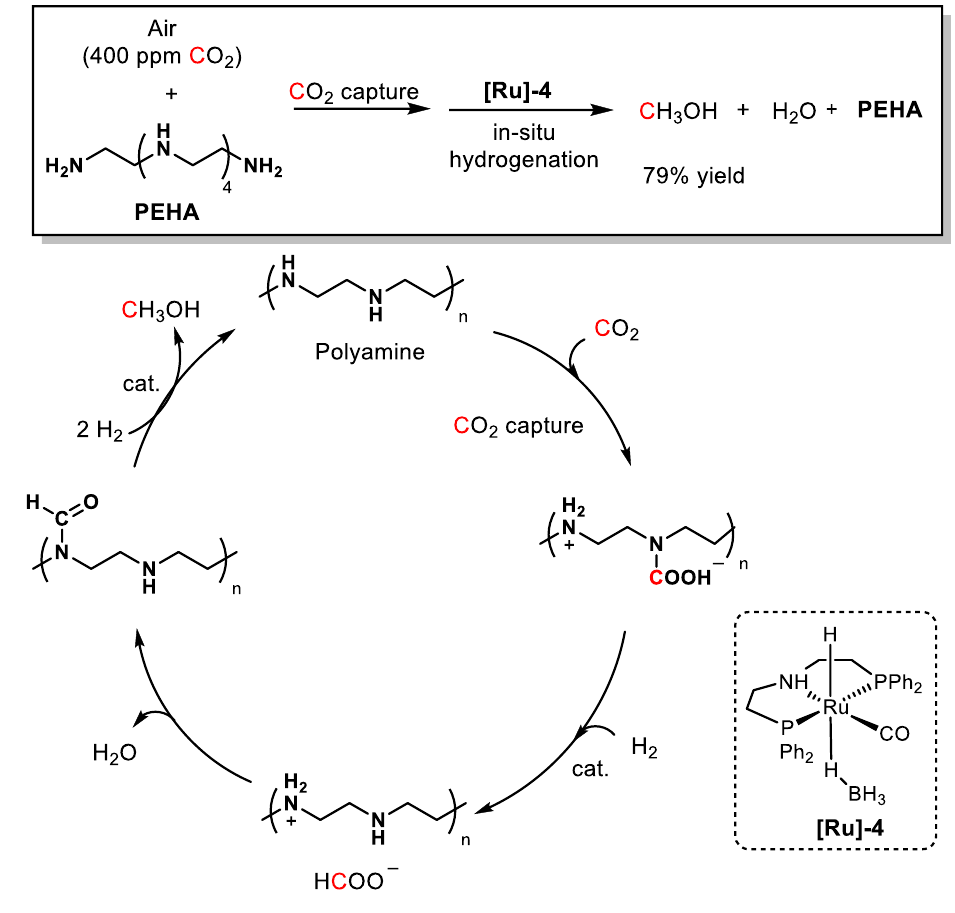
Figure 7. PEHA as capture reagent for CO 2 hydrogenation from air.